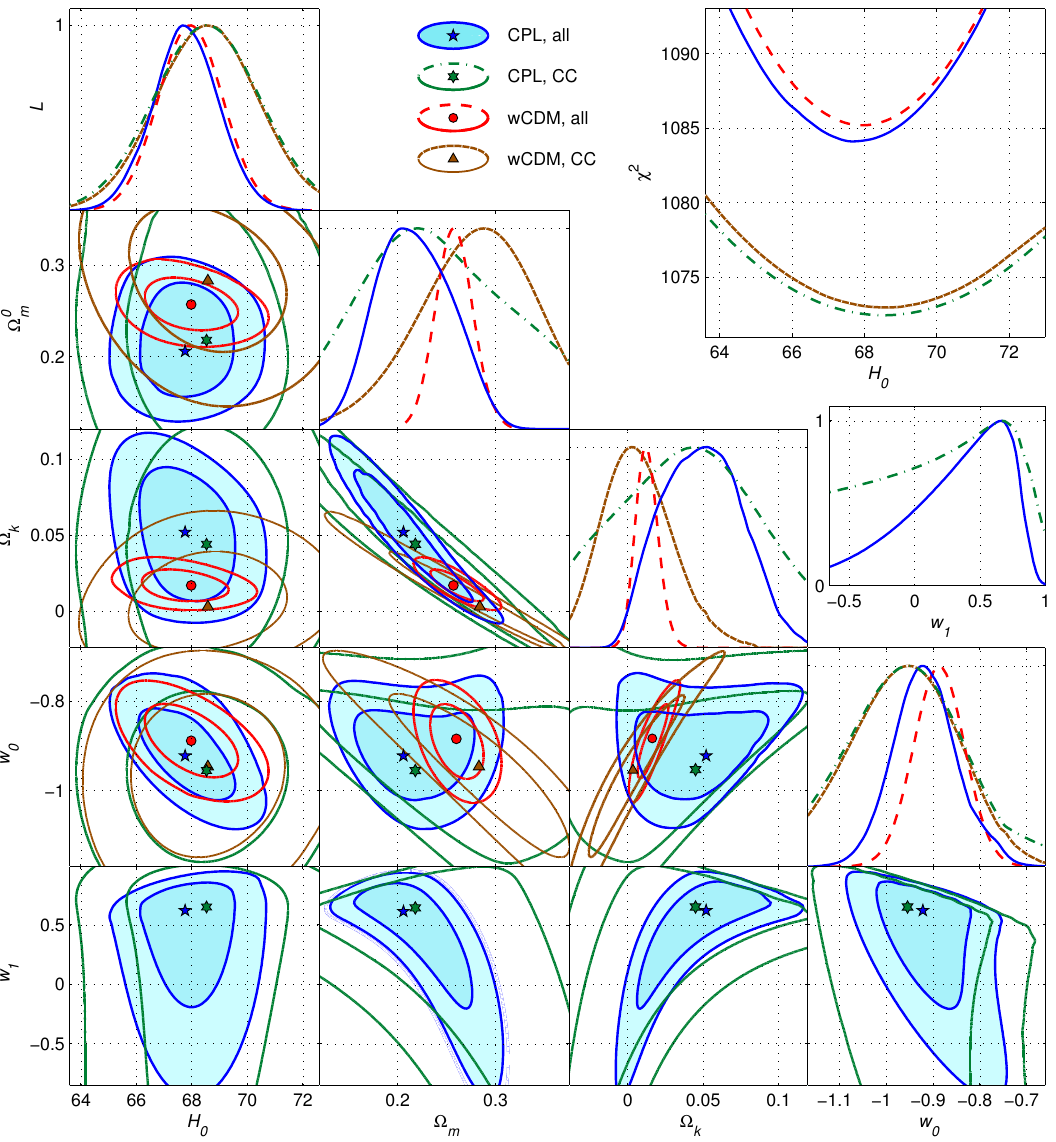
Figure 2. CPL model (23) in comparison with the w CDM model: 1 σ , 2 σ contours, likelihoods L ( θ j ) , and one-parameter distributions χ 2 tot ( H 0 )